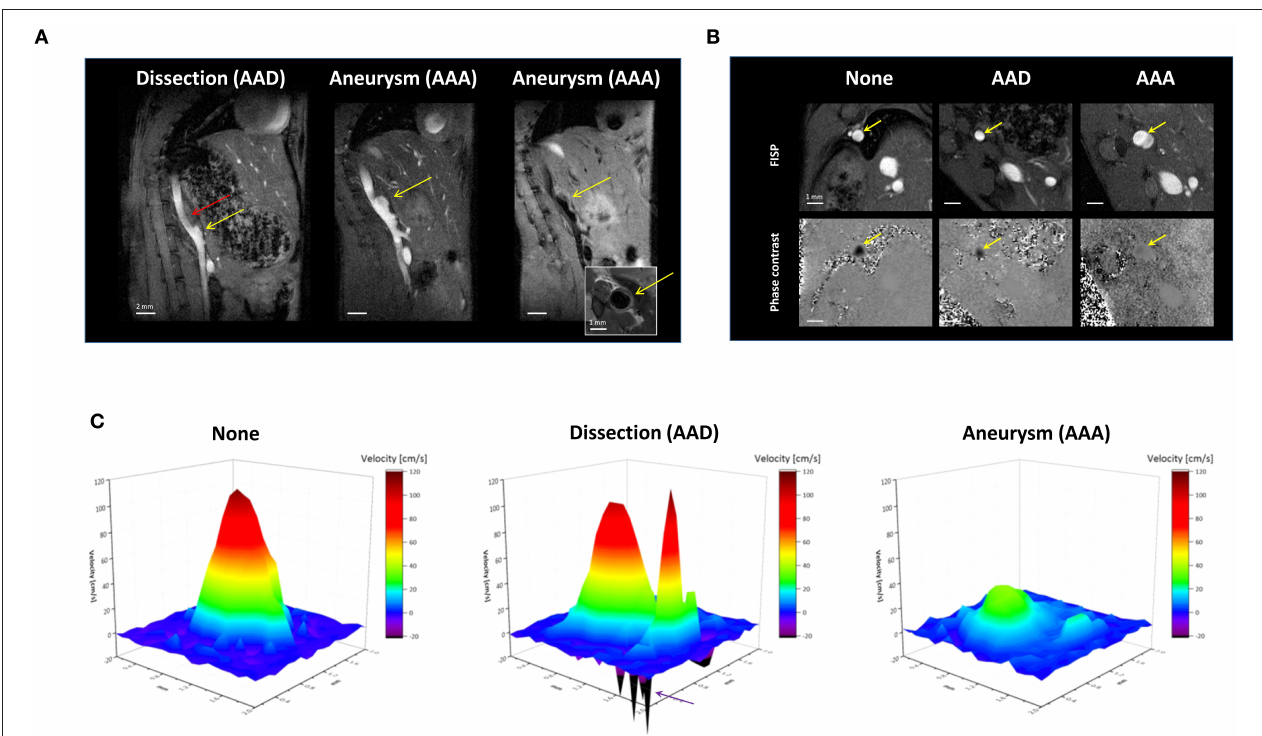
FIGURE 2 | Hemodynamic consequences of angII-induced vessel alterations. (A) End-diastolic sagittal images from 1 H cine bright blood movies in AAD (left) and AAA (middle). Right: Corresponding 1 H black blood images acquired in the same orientation as in the adjacent bright blood image as well as in perpendicular orientation (insert). (B) Upper panel: Cross-sectional bright blood images of mice without AAA/AAD (None) and with AAD (middle) or AAA (right). Lower panel: Anatomical corresponding phase contrast MR images acquired in end-systole. (C) 3D surface plot of the flow velocity profiles shown in (B) . Normal aorta (control, left); AAD (middle) and AAA (right). The purple arrow marks the sites of reverse flow.